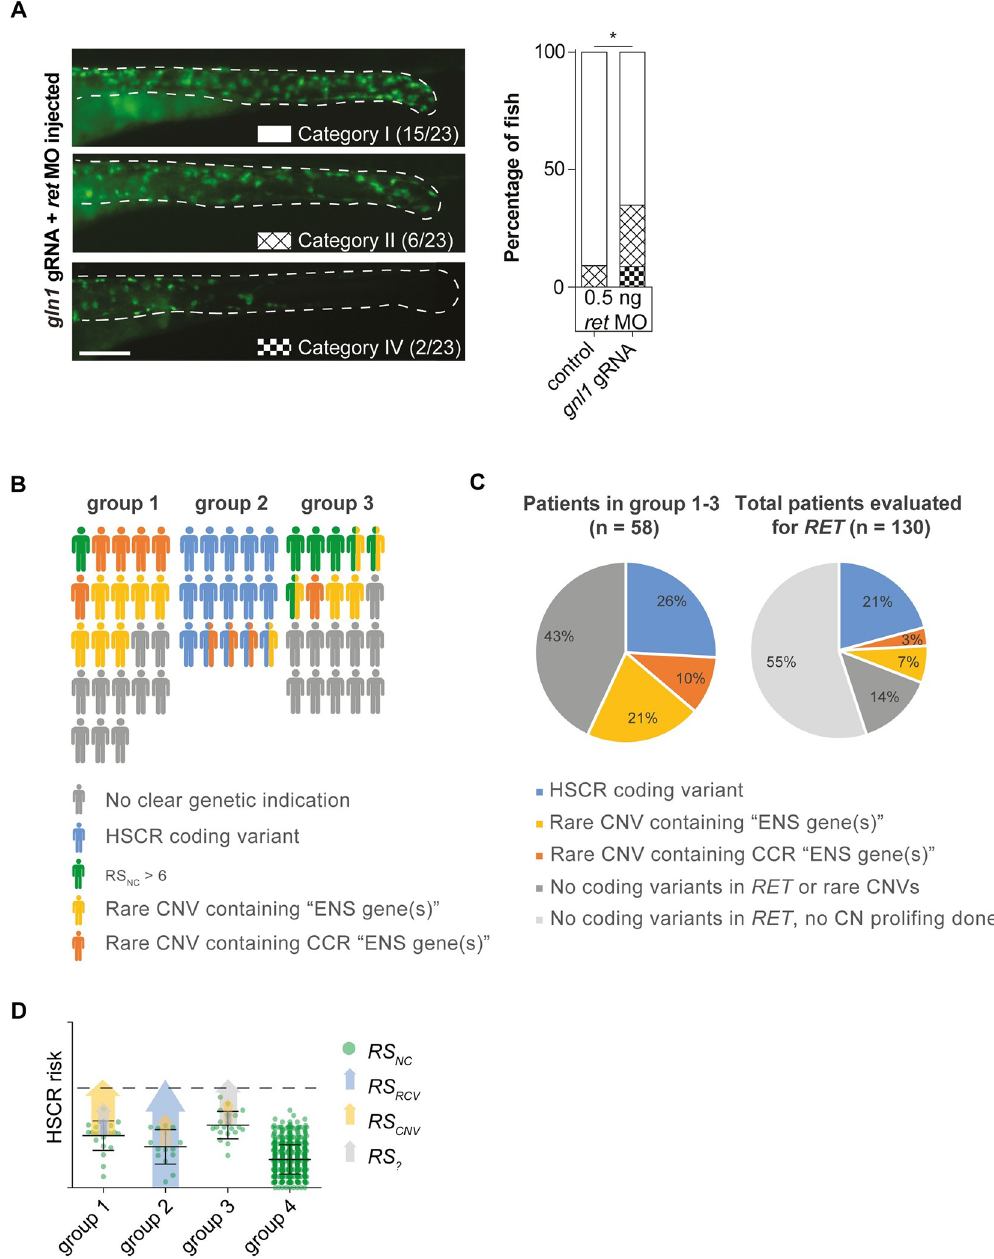
Fig 5. Complex HSCR genetics: Epistasis between ret and gnl1 and genetic predispositions of HSCR patient groups. (A) A second injection round targeting gnl1, using a lower dose of ret morpholino, confirmed gnl1 epistasis with Ret. Statistical tests used: "N-1" Chi-squared test; � p < 0.05 (B) Visual representation of the distribution of genetic predispositions over HSCR patient groups. In total 197 patients born between 1973 and 2018 were evaluated by a clinical geneticist in the department of Clinical Genetics, Erasmus Medical Center, Rotterdam. Of these, 114 did not have associated anomalies nor a known syndrome. 29 patients had a known HSCR related genetic syndrome, including Down syndrome (n = 18). 153 out of 197 patients were genetically evaluated for RET gene involvement and 21 had a pathogenic RET variant. (C) Pie charts showing the incidence of rare CNVs containing “ENS genes”, CCR “ENS genes” and coding variants in HSCR patients. (D) Graphical representation of a hypothetical model explaining the relative contributions of the risk scores in our 3 patient groups. Error bars represent standard deviation.